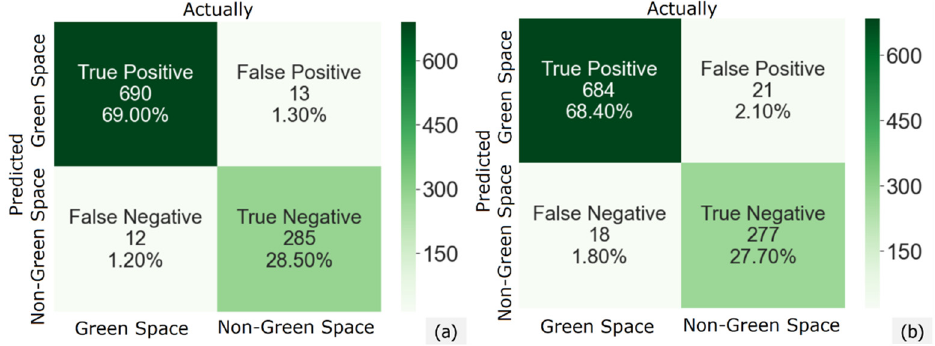
Figure 14. Confusion matrices of the green space areas verification results by analyzing greenness values on Landsat 8 satellite image ( a ) and by LULC data ( b ) at 1000 locations as shown in Figure 13.